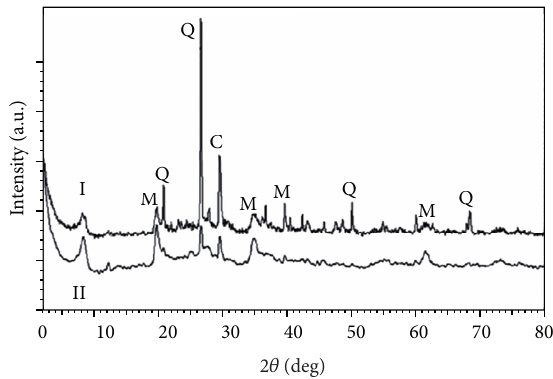
F 2: �R� patterns for (I) raw bentonite and (II) puri�ed bentonite, M: montmorillonite, Q: Quartz, and C: calcite.